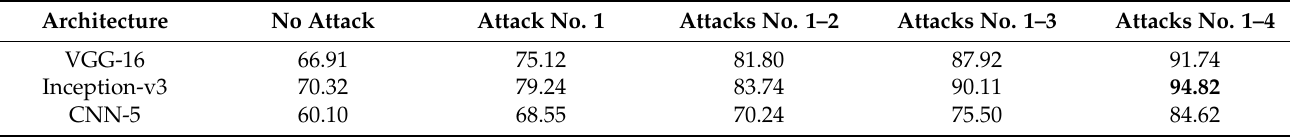
Table 6. Percentage of correct Kaggle.Dogs vs. Cats image recognitions with prevention of visual attacks.